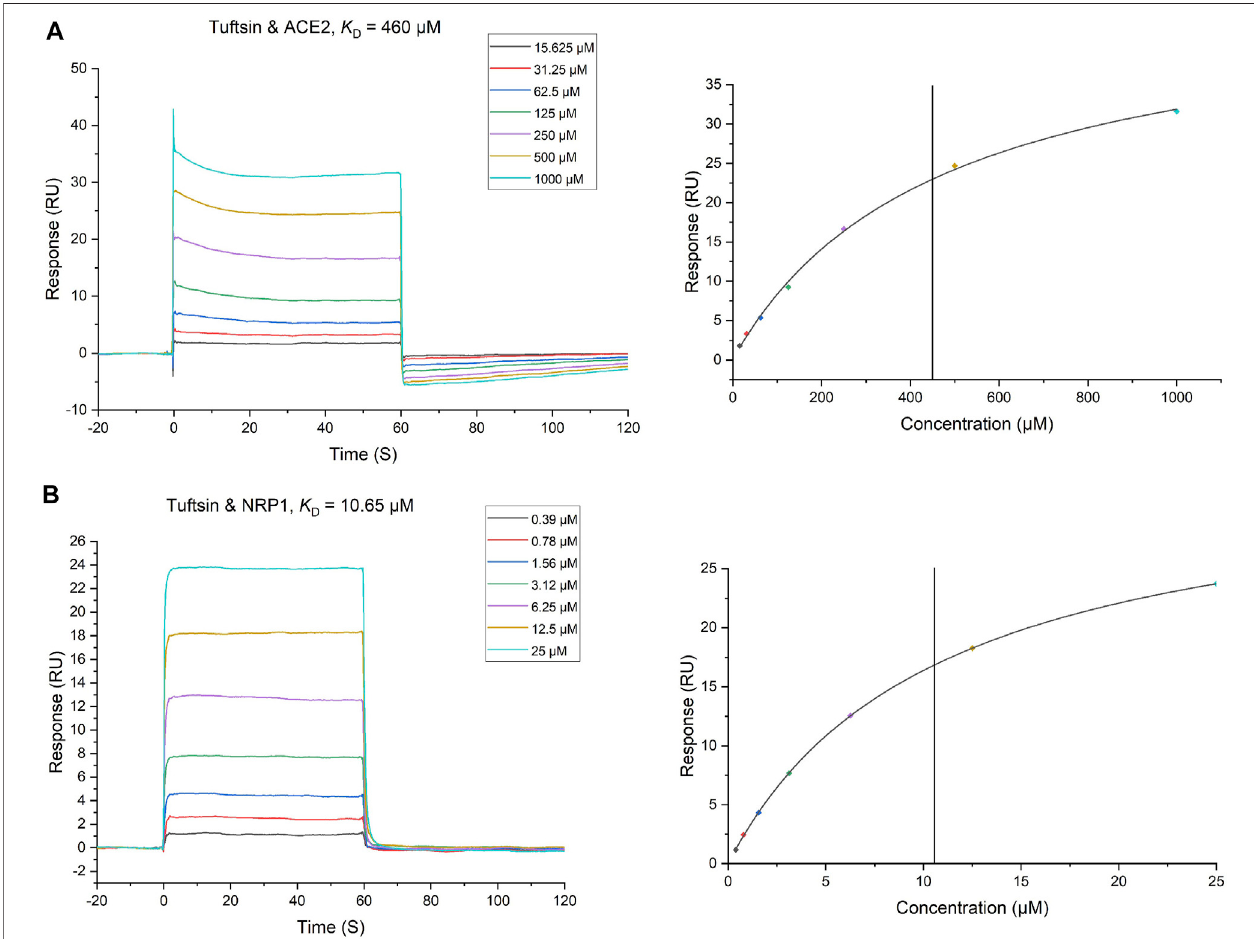
FIGURE3| ThebindingoftuftsintoACE2andNRP1wasdeterminedbySPRassay. (A) (Left)BindingcurvesoftuftsinwithACE2.The K D oftheACE2proteinwith aseriesofconcentrationsoftuftsinwascalculatedbyusinga1:1bindingmodel.Dataarepresentedasresponseunits(RU)overtime(S).(Right)The fi ttingcarveoftuftsin with ACE2. (B) (Left) Binding curves of tuftsin with NRP1. The K D of the NRP1 protein with a series of concentrations of tuftsin was calculated by using a 1:1 binding model. Other interpretations are the same as above. (Right) The fi tting carve of tuftsin with NRP1.